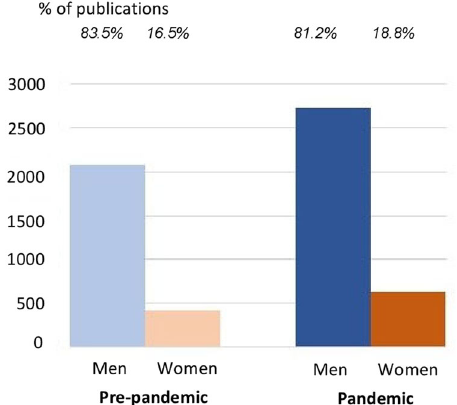
Fig. 1 Average number of submissions/month by gender and pandemic period (comparing men and women). The percent of corresponding authors who self-identi fi ed as non-binary was 1.6% in the pre-pandemic period and 3.2% in the pandemic